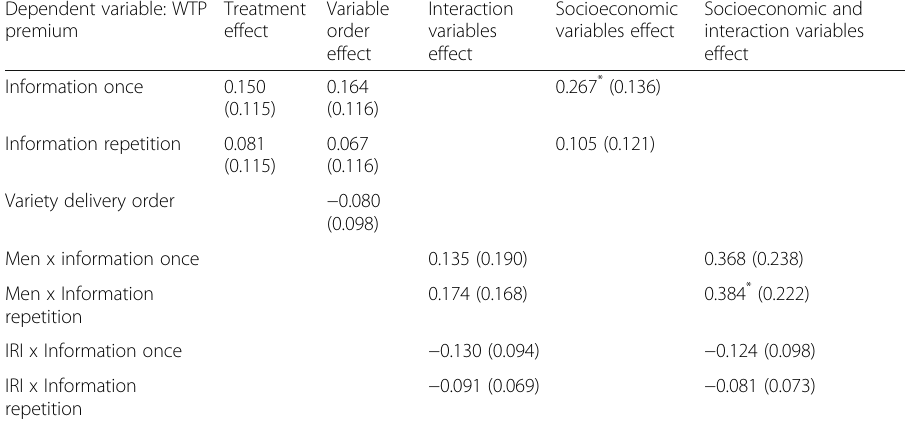
Table 6 Premium (WTP) for the iron bean variety in Guatemala (Ordinary least square model (OLS)